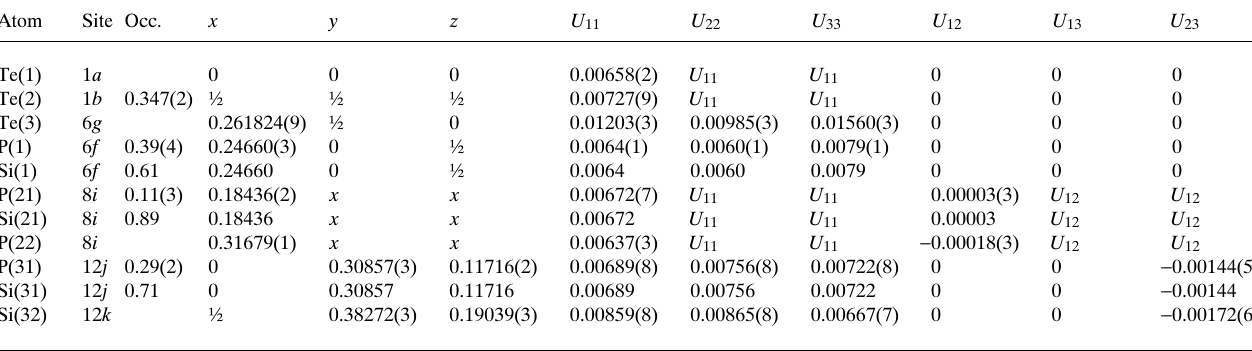
Table 2. Atomic coordinates and displacement parameters (in Å 2 ) .